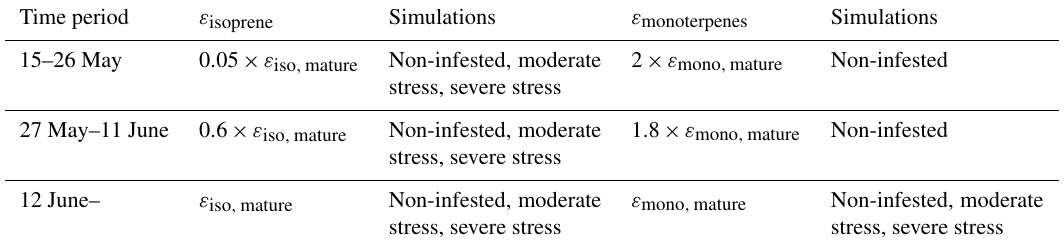
Table B1. Modifications done in order to consider the effect of leaf age. ε isoprene and ε monoterpenes are the emission factors of isoprene and monoterpenes, respectively, used in the simulations when the leaf age effect has been considered, while ε iso , mature and ε mono , mature are the emission factors of isoprene and monoterpenes, respectively, used in the default simulations (i.e. resulting in Figs. 5–6). The modifications have been applied to the simulations of either only non-infested oak or both non-stressed and stressed oak as indicated under “simulations”. Time